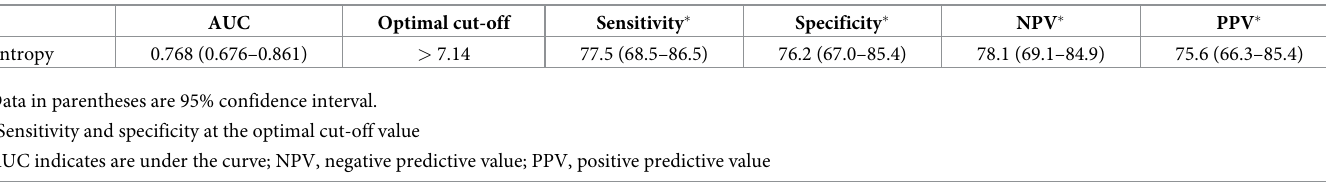
Table 3. Receiver operating characteristics analysis for